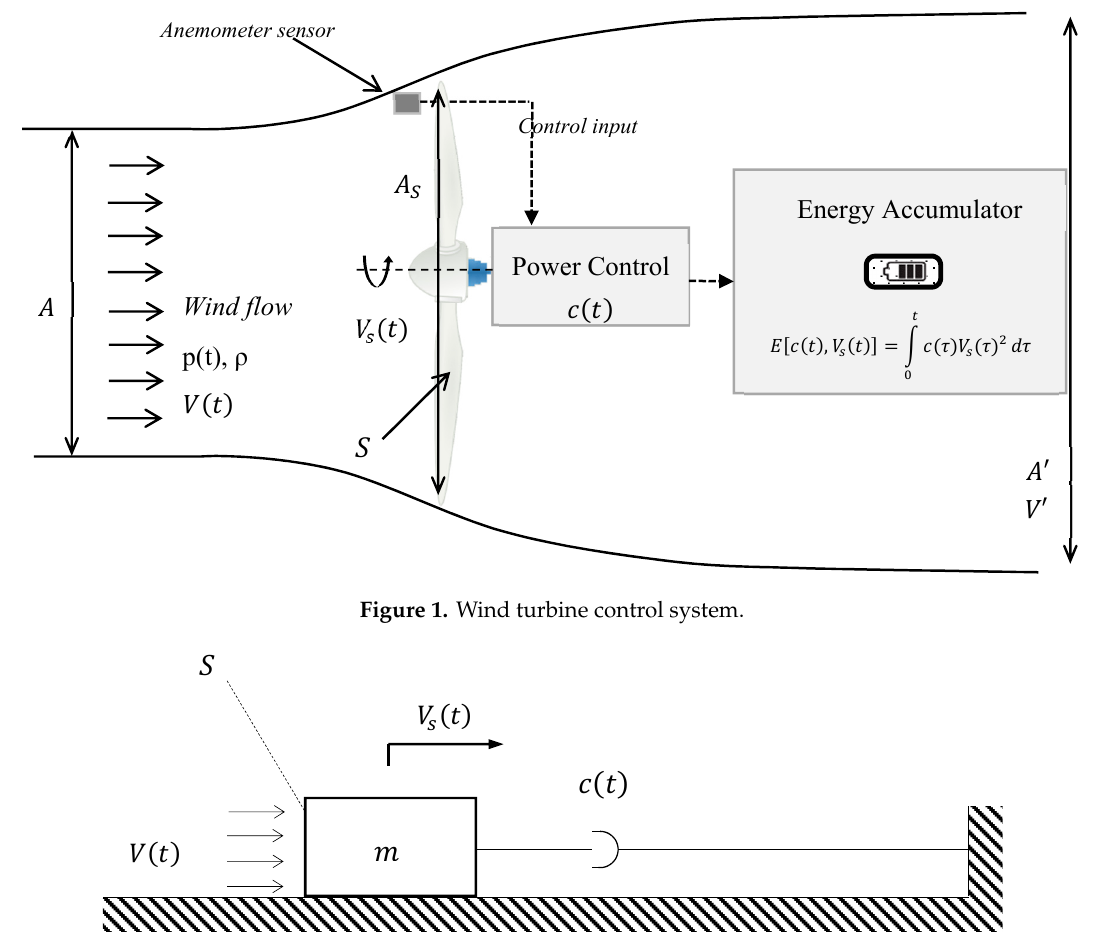
Figure 2. The wind turbine dummy model.